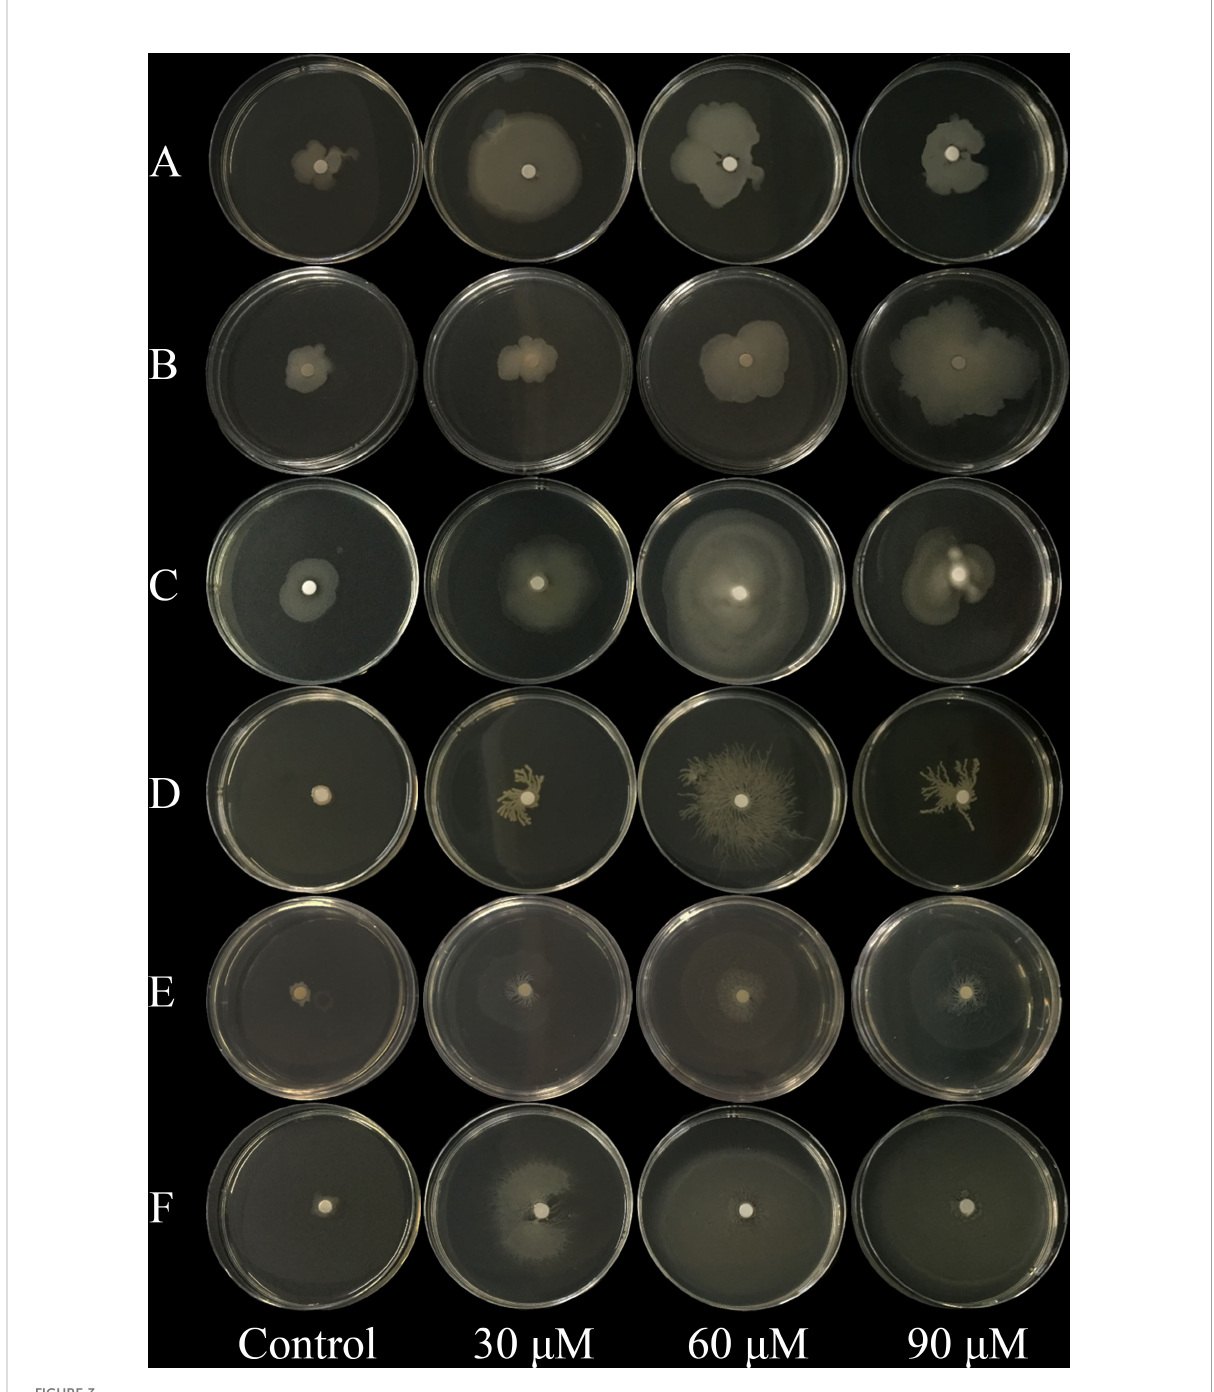
FIGURE 3 Effect of chemoattractants on the swarming motility of Bacillus cereus strain CP1 and Pseudomonas sp. (A – C) Bacillus cereus strain CP1; (D – F) : Pseudomonas sp. (A, D) Chemoattractant 2, 4-di-tert-butylphenol; (B, E) chemoattractant methyl stearate; (C, F) chemoattractant arginine. Chemoattractant concentration from left to right: 0, 30, 60, and 90 m